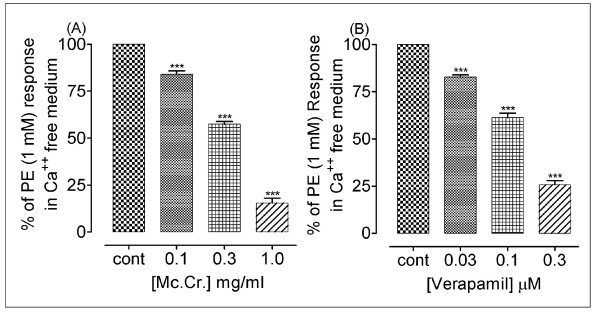
Bar chart showing the inhibitory effects of (A) Mc.Cr and (B) verapamil on PE responses in Ca++-free Krebs solution in isolated rabbit aorta preparations. ***P < 0.001; shows a comparison of dose dependent effect on phenylephrine (PE 1 μM) rabbit aorta.